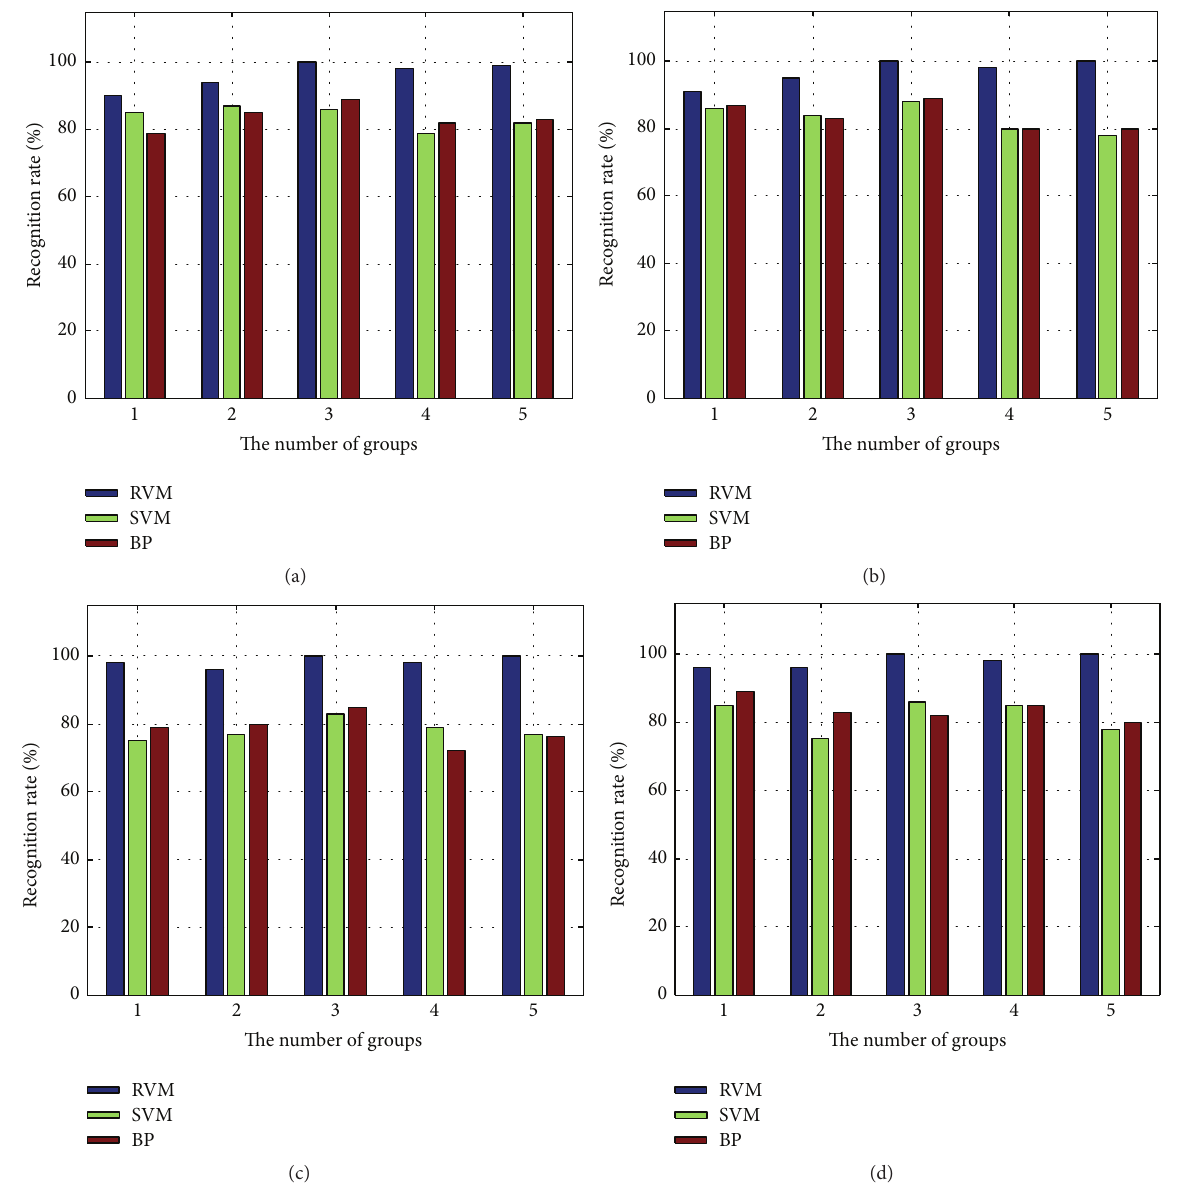
Figure10:(a)Recognitionrateofnormalstate.(b)Recognitionrateofrollingelement.(c)Recognitionrateofinnerringfault.(d)Recognition rate of outer ring fault.